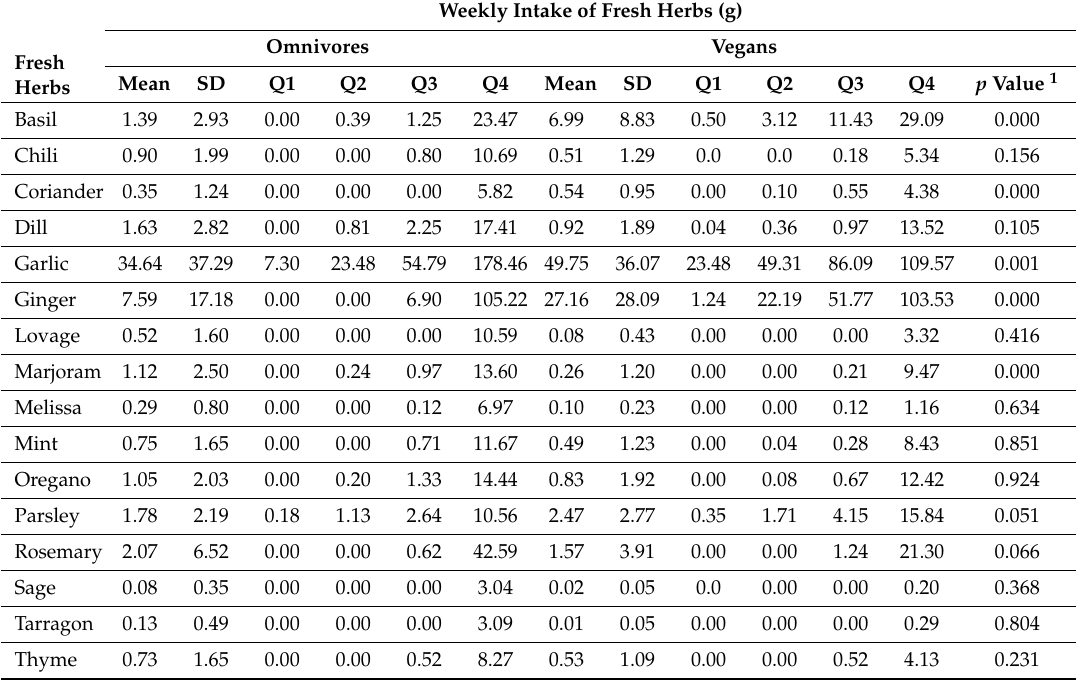
Table 3. Weekly intake of fresh herbs among adult omnivores and